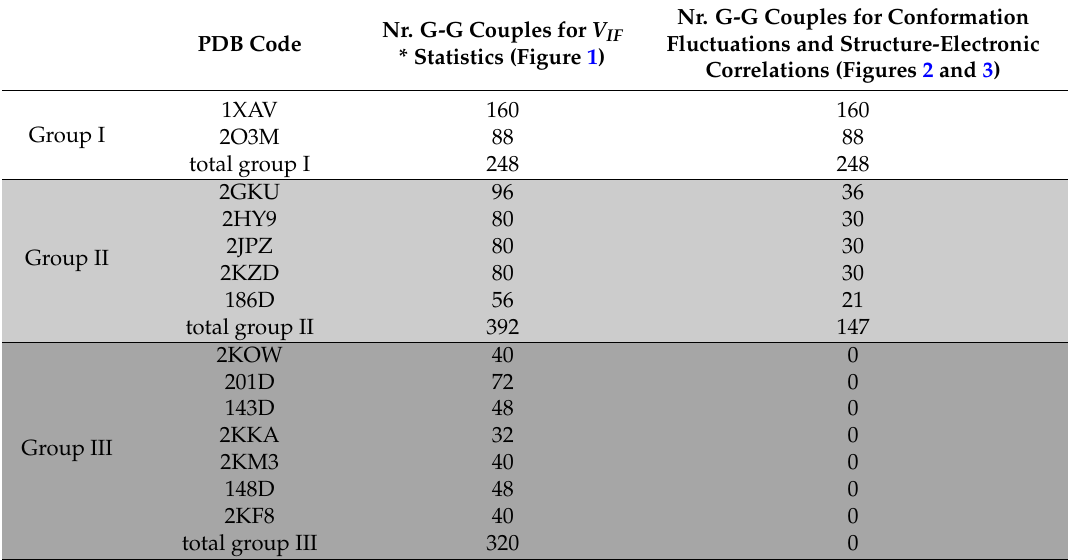
Figure 2. Top: illustration of the inter-base helix parameters between stacking guanines. Bottom: heat mapss of the structural and electronic parameters on which correlations have been evaluated. The 7 structures of group I and group II are arranged on the vertical axis, from bottom to top in each panel: PDB ID 1XAV, 2O3M, 2GKU, 2HY9, 2JPZ, 2KZD, 186D. The horizontal axis represents the different representative conformations (or NMR model) deposited for each structure in the nucleic acid database (details in Table 3). The scale is shown on the right vertical axis: HL and V IF are in eV, rise and shift are in Å , twist and roll are in degrees. Table 3. Number of G-G couples from the G-quadruplex for the analysis in Figures